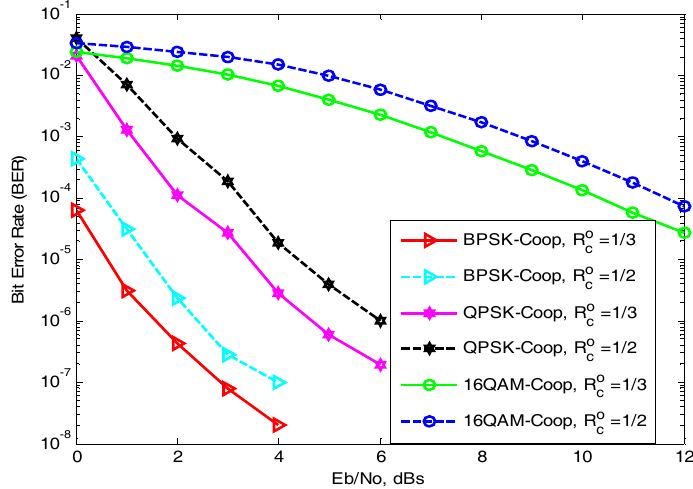
Figure 10. BER performance of turbo coded OFDM with MIMO (2 × 2) antennas in coded-cooperation under different code rates, based on CMI, L = 1024 , four decoding iterations.